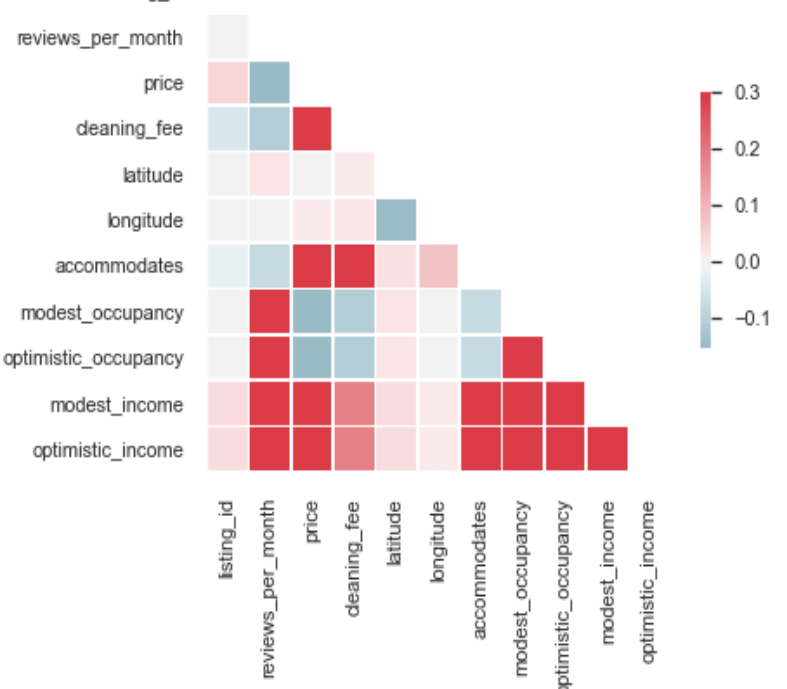
Figure 2. Correlation matrix heatmap for the